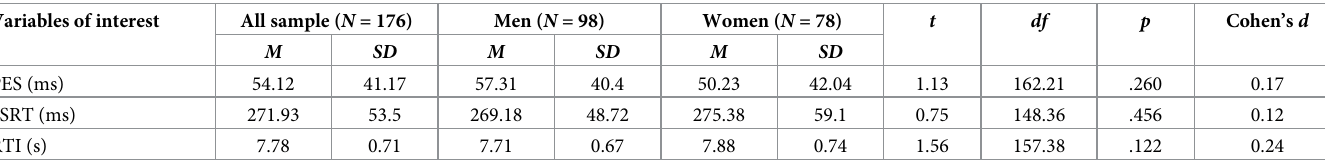
Table 1. Means (M) and standard deviations (SD) of the post-error slowing (ms), the Stop Signal reaction time (ms) and the press duration (s) in the BART. Variables of